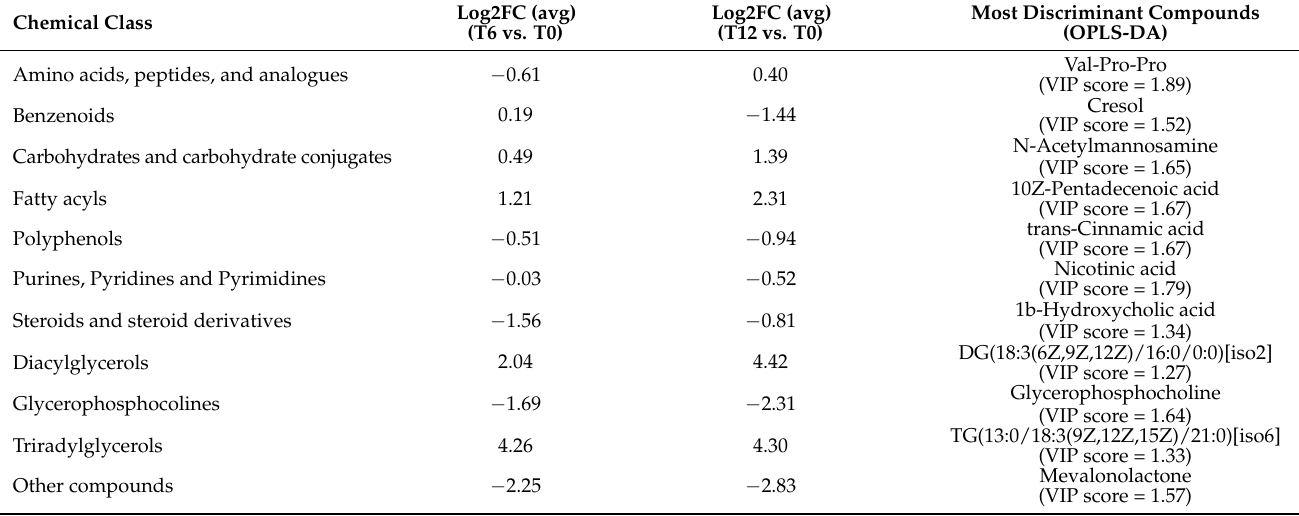
Table 4. Changes (expressed as average Log2 Fold-Change values) during shelf-life of the chemical classes annotated using UHPLC-QTOF mass spectrometry. The most discriminant compound (VIP marker) for each class is also reported.